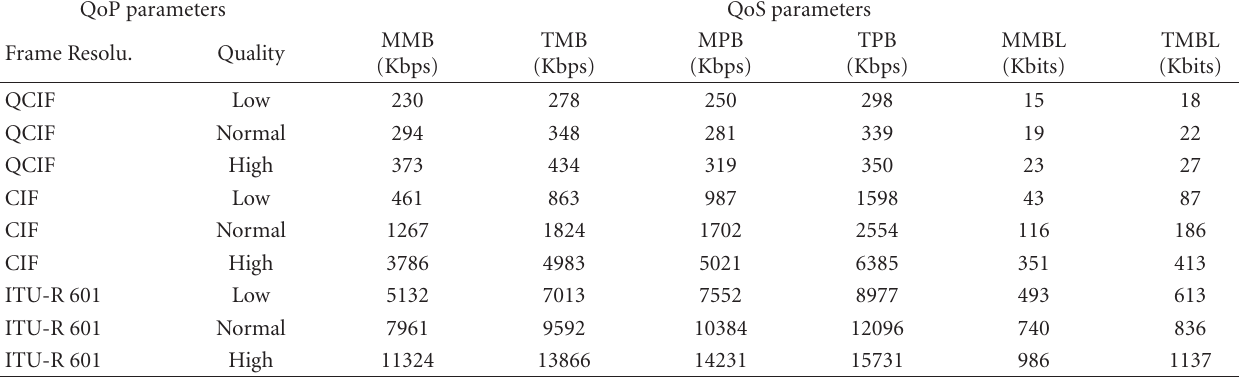
Table 2: General QoP/QoS mapping